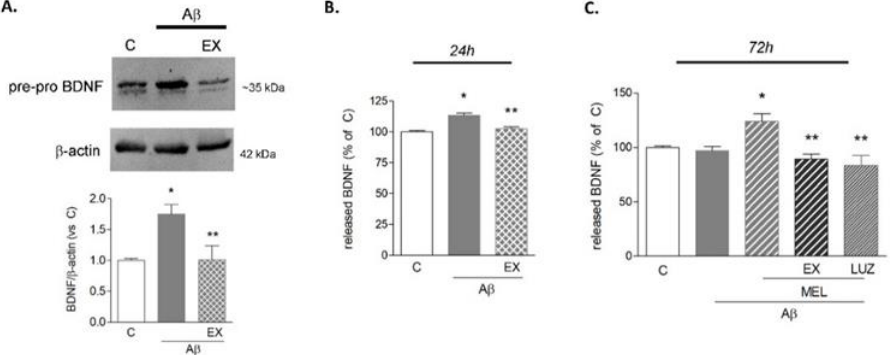
Figure 1. BDNF expression in HMC3 cells upon Aβ42 exposure. In ( A ) and ( B ), cells were treated with Aβ42 (0.2 μM) alone or in combination with SIRT1-selective inhibitor EX527 (EX, 5 μM). In ( A ), Western blot analysis of the intracellular content of BDNF at 6 h in the presence of brefeldin A (5 μg/mL). A representative blot is shown. ELISA determinations of released BDNF are reported at 24 h ( B ) and 72 h ( C ). In panel ( C ), melatonin (MEL, 1 μ M) was added to Aβ42, alone or in combination with EX or luzindole (LUZ, 25 μ M). Results are the mean ± SEM of 3–5 independent experiments. * p < 0.05 vs. C and ** p < 0.05 vs. Aβ ( B ) or vs. A β +MEL ( C ) by one-way ANOVA followed by Newman Keuls test for significance.